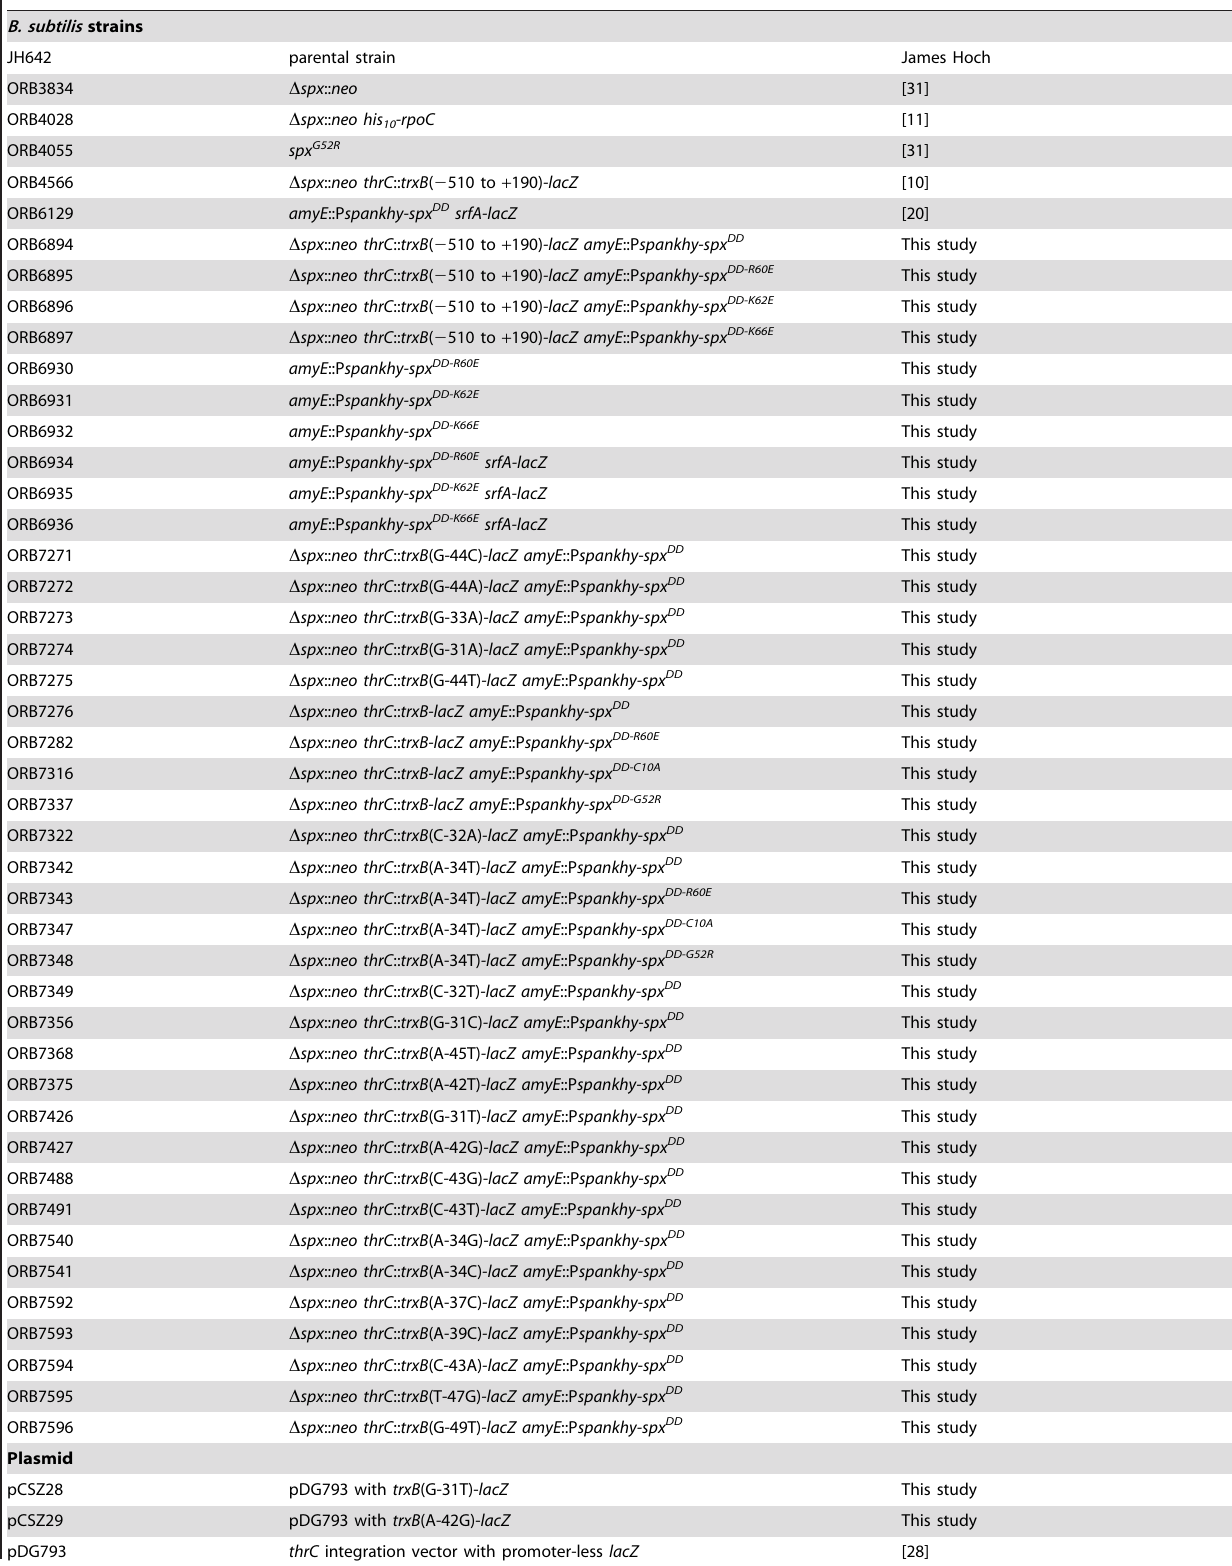
Table 2. B. subtilis strains and